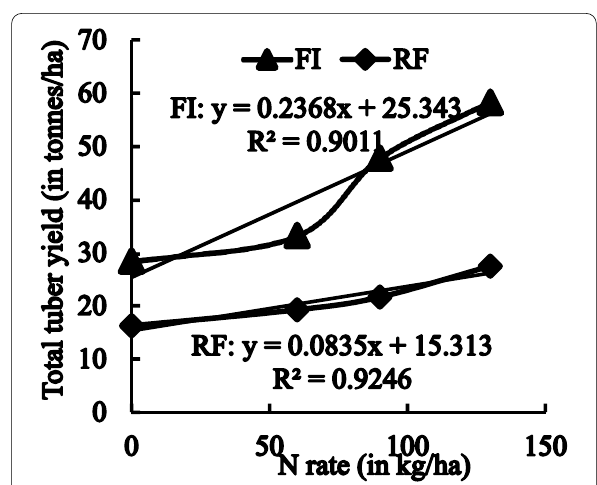
Fig. 6 Relationship between total tuber yield and N-rates under different irrigation treatments